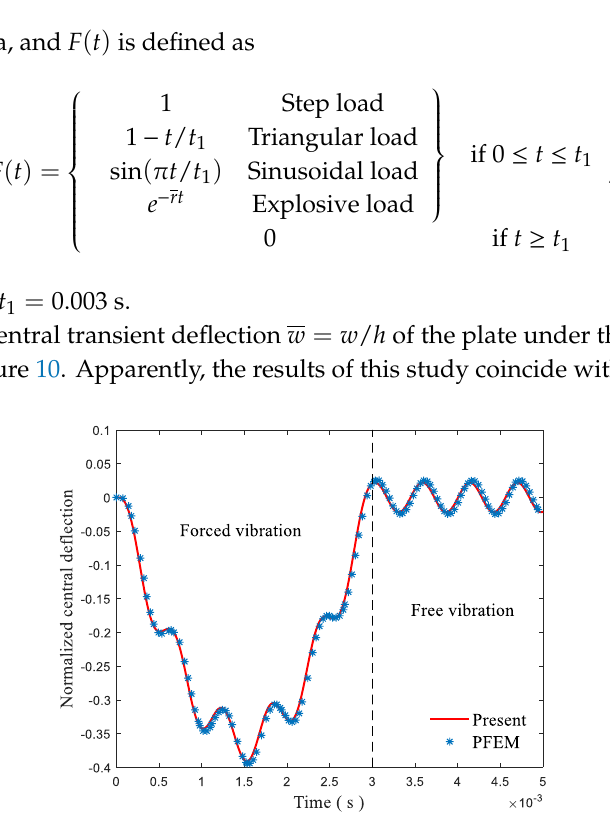
Figure 10. Transient normalized central deflection of a SSSS FGP with 1 n .